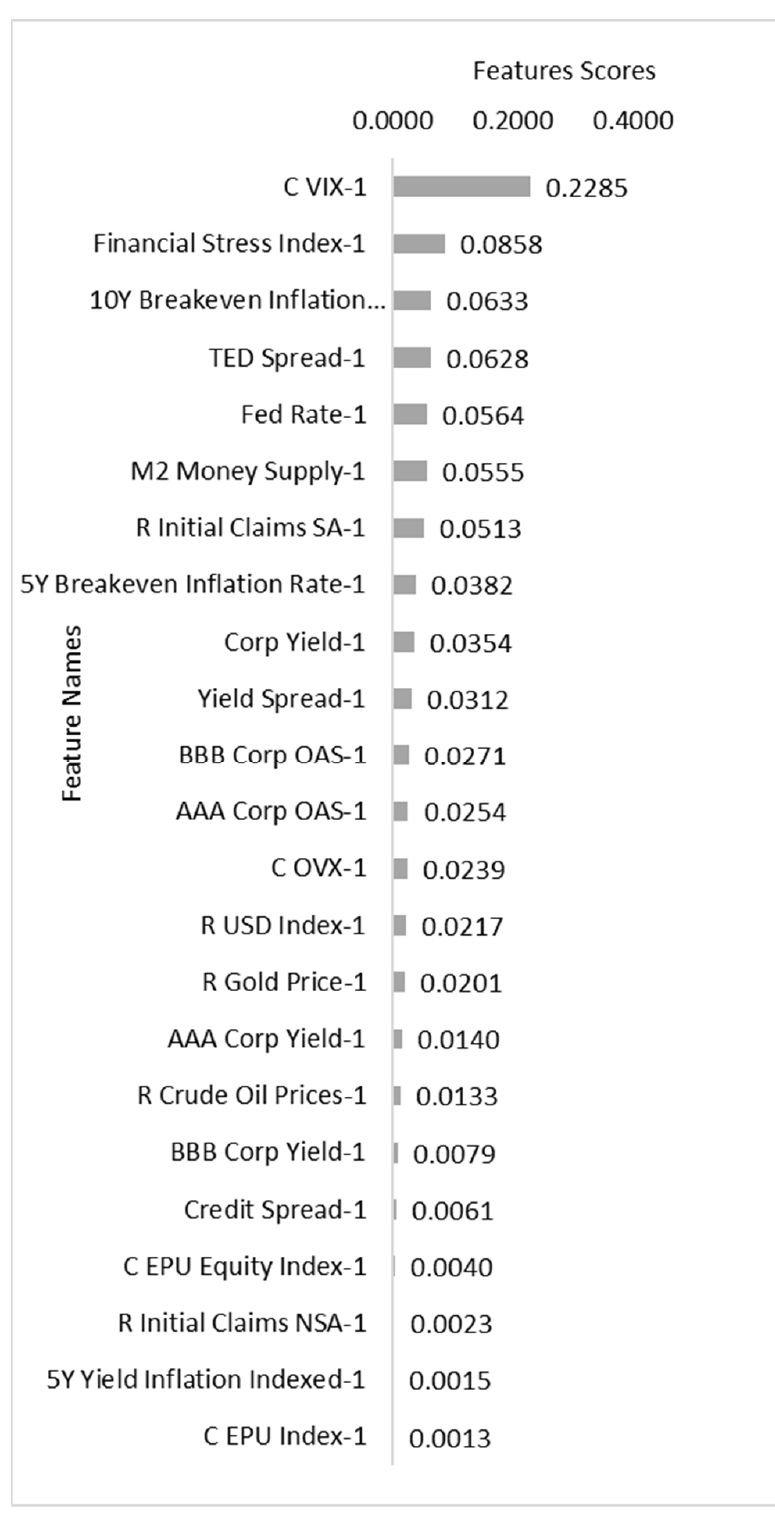
Figure 4. Top twenty-three weekly ranked features from Light GBM. The numbers on the right, truncated to four decimal places, are the features’ scores.